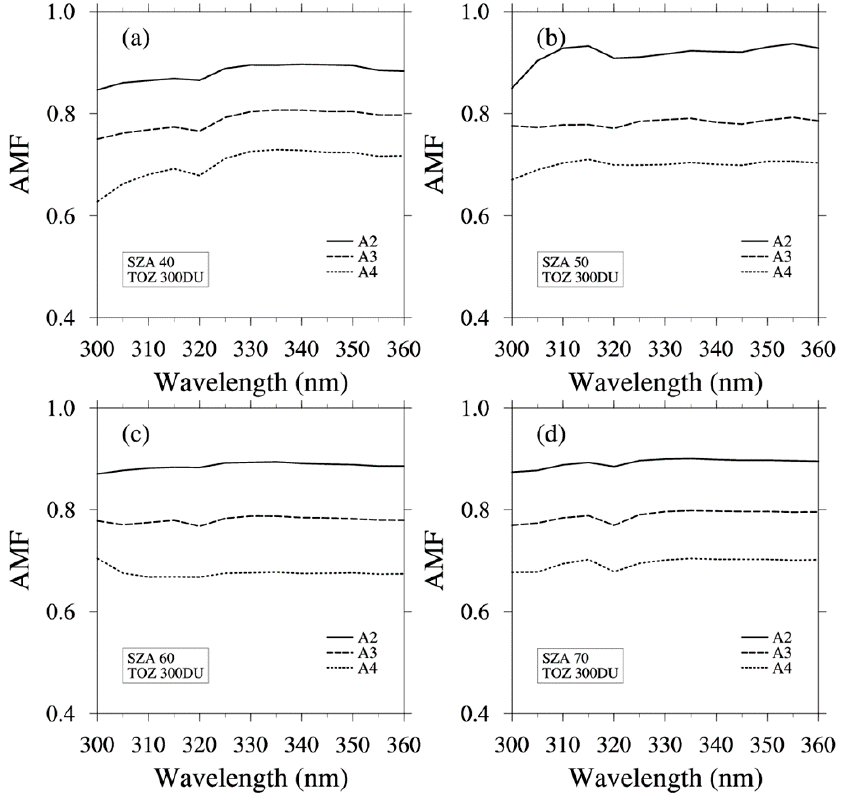
Figure 8. Spectral AMF of each AOD categories at SZA of: ( a ) 40°; ( b ) 50°; ( c ) 60°; and ( d ) 70°. Table 8. The AMF values as a function of wavelength for each AOD categories.